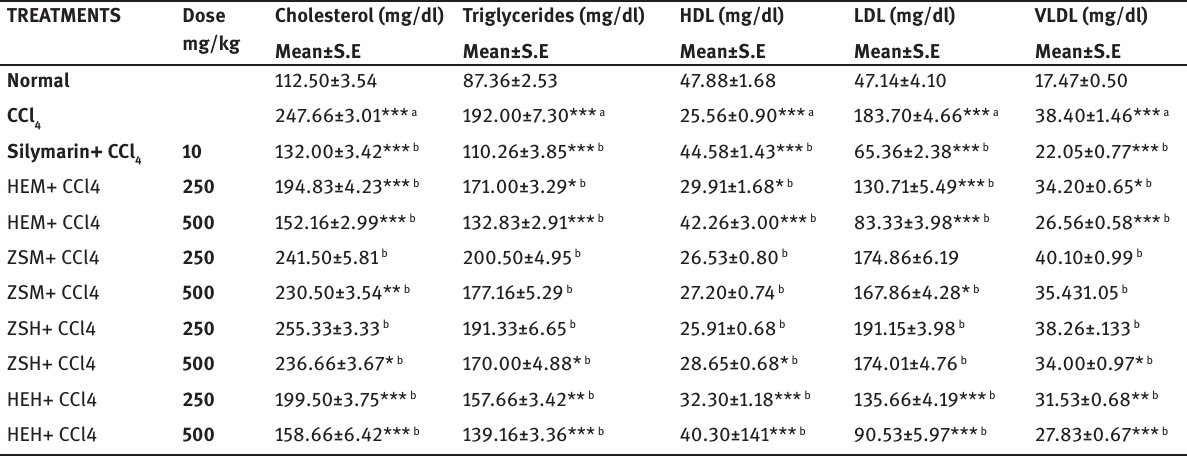
Table 2: Effect of Extracts on metabolism and serum lipoproteins of control and treated rats. TREATMENTS